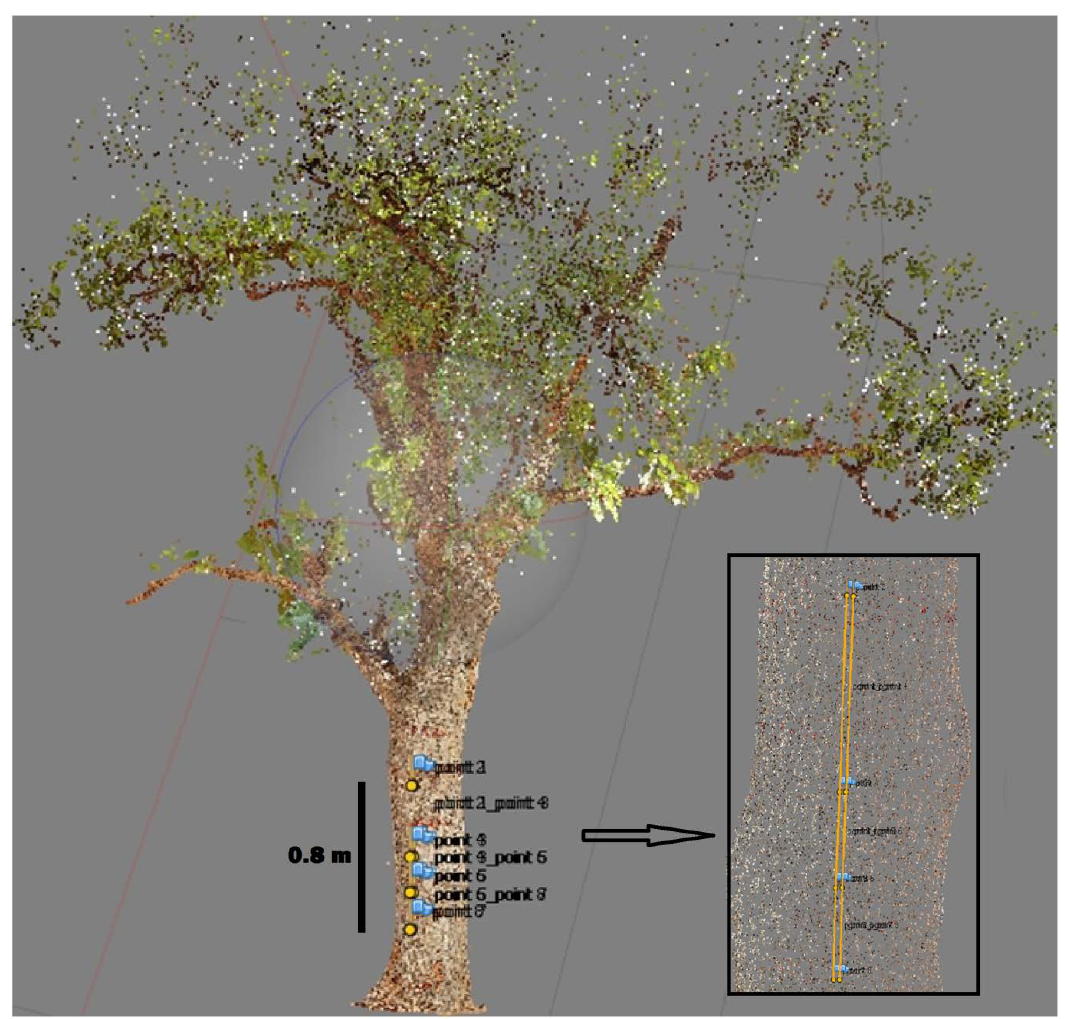
Figure 3. Scaled 3-D model of V. paradoxa. Image acquisition was on a circular path, 1 m from the stem, based on 15 ◦ angular